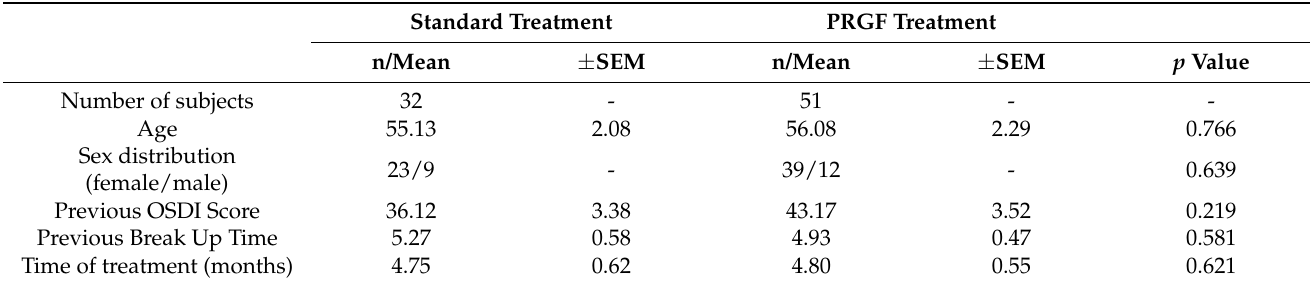
Table 1. Demographics and inclusion